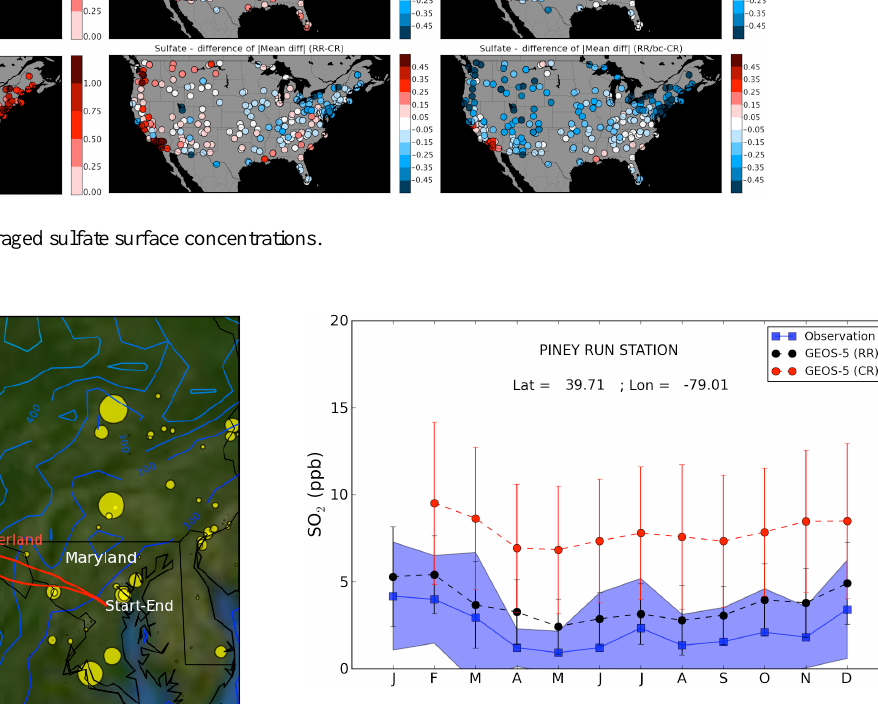
Fig. 8. Frostburg campaign regional map. Yellow circles are coal- fired power plant stations; the circle size is proportional to the emis- sion rates. Piney Run station denoted by the white symbol (cid:5) is lo- cated at 39.70 ◦ N and 79.01 ◦ W. Cumberland (in pink) is located at 39.62 ◦ N and 78.77 ◦ W and the Frostburg State University (in blue) is located at 39.65 ◦ N and 78.93 ◦ W. Flight track on 8 Novem- ber 2010 is in red. Blue lines show the topography.